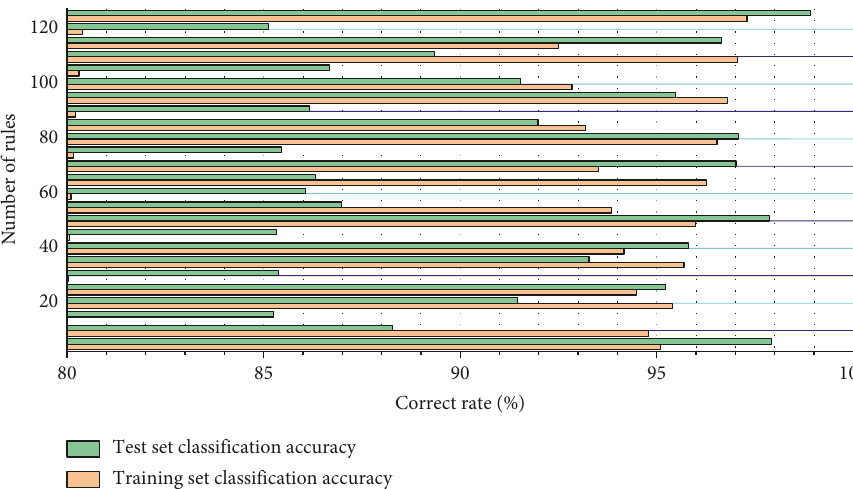
Figure 3: Comparison of classification accuracy of training and testing datasets under different rules of a decision tree.